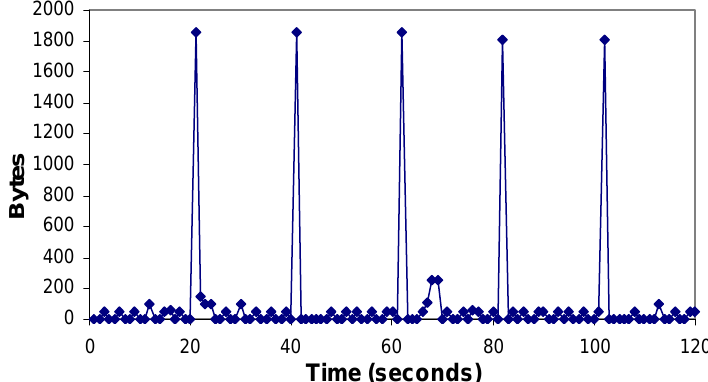
Figure 18. Bytes per second when there is an